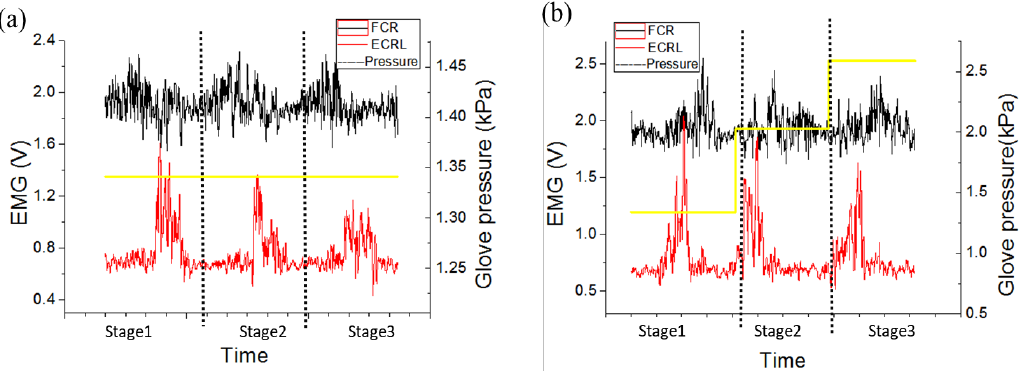
Figure 12. Muscle intensity monitoring for robotic glove controlling ( a ) without and ( b ) with an adaptive strategy.